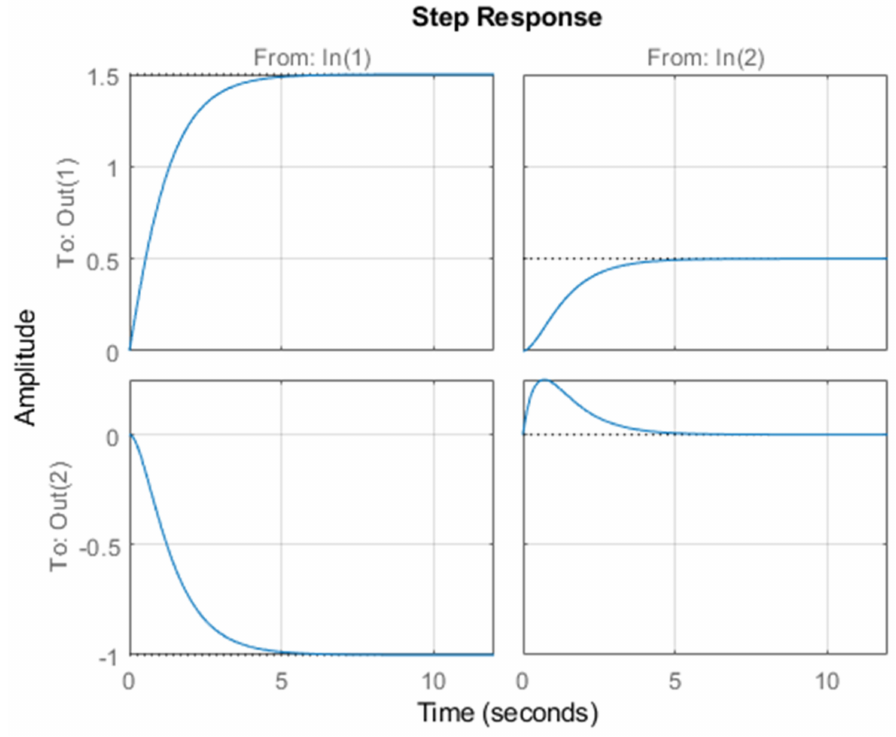
Figure 1. Open loop system unit-step time